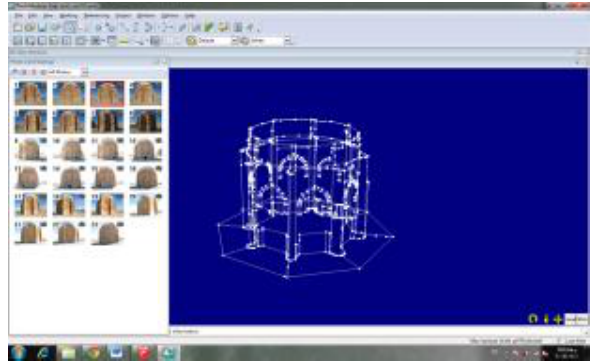
Figure 6. The image processing in PhotoModeler and generating the wireframe model of the